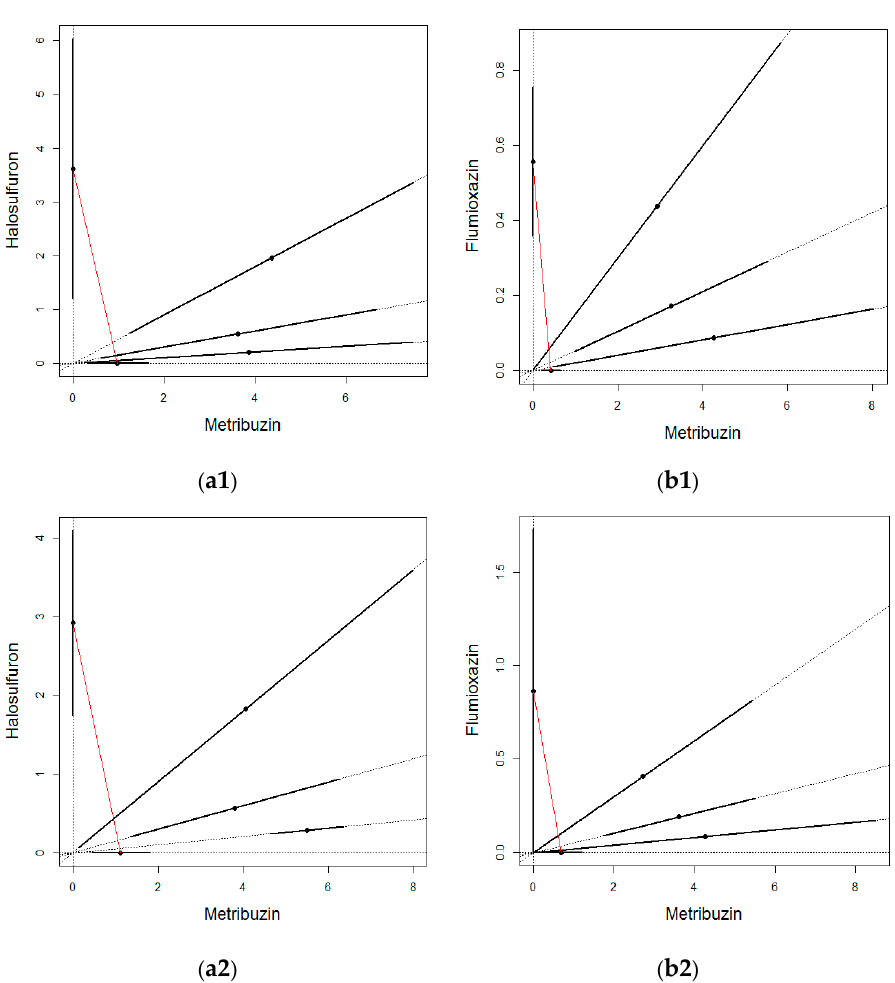
Figure 1. ED 50 isobologram showing the interactions of metribuzin:halosulfuron ( a ) and metribuzin:flumioxazin ( b ) on fresh weight C. album in first experiment ( 1 ) and second experiment ( 2 ). The straight line of the isobologram indicates additivity. The lines around the mixture points have 95% confidence intervals.